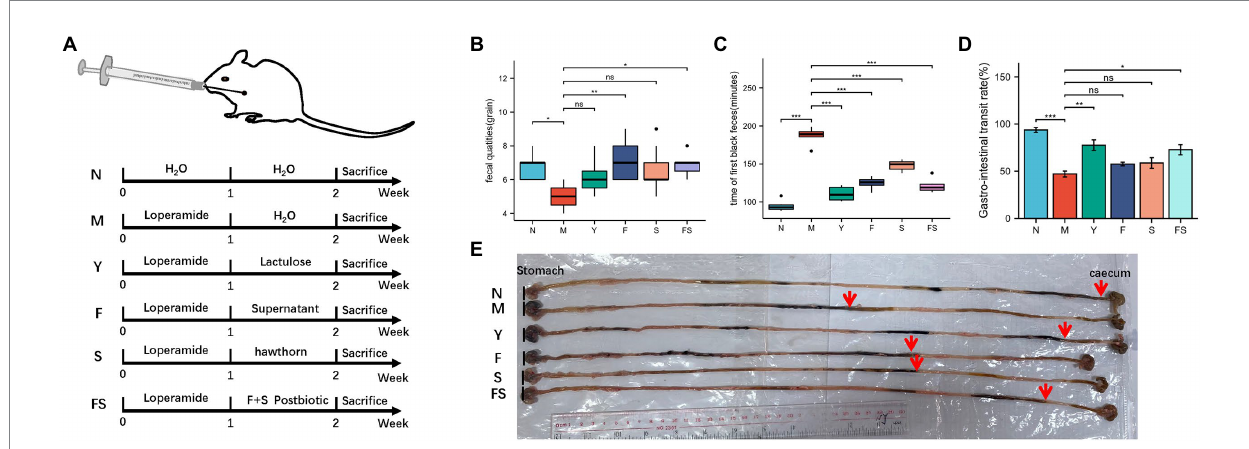
FIGURE 1 Postbiotic of hawthorn-probiotic can increase intestinal motivity. (A) Animal models and treatment; (B) fecal quantities 10 min after intragastric administration; (C) time of first black feces after being intragastrically fed with ink on the day of sacrifice; (D) intestinal transport ratio (GI = ink movement length/total intestinal length*100%); (E) moving distances of each group of inks. NS; * p < 0.05; ** p < 0.01; *** p <